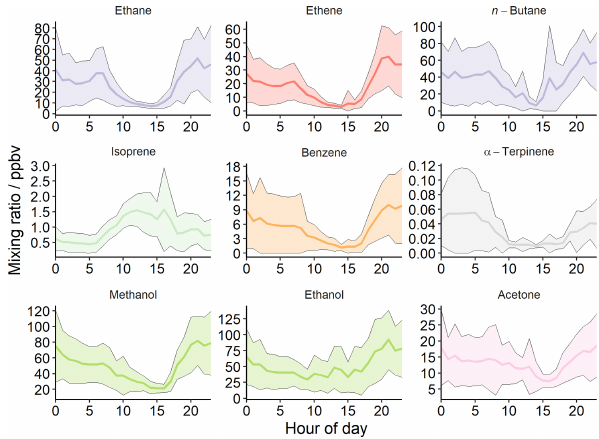
Figure 6. Mean campaign-averaged diel mixing ratio profiles of selected VOCs during the campaign: ethane, ethene, n -butane, isoprene, benzene, α -terpinene, methanol, ethanol, acetone. The shaded ribbon represents 1 standard deviation from the mean. Colours correspond to the different VOC classes.